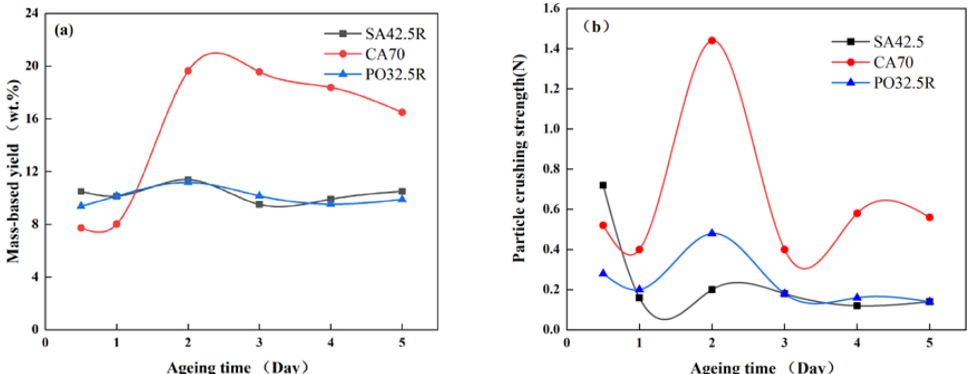
Figure 6. Comparison of the CA70, SA42.5, and PO32.5R cement-bonded oxygen carriers during the aging of the cubic samples: ( a ) mass-based yield of particles having sizes from 106–300 μ m and ( b ) crushing strength of particles with sizes ranging from 106–300 μ m.